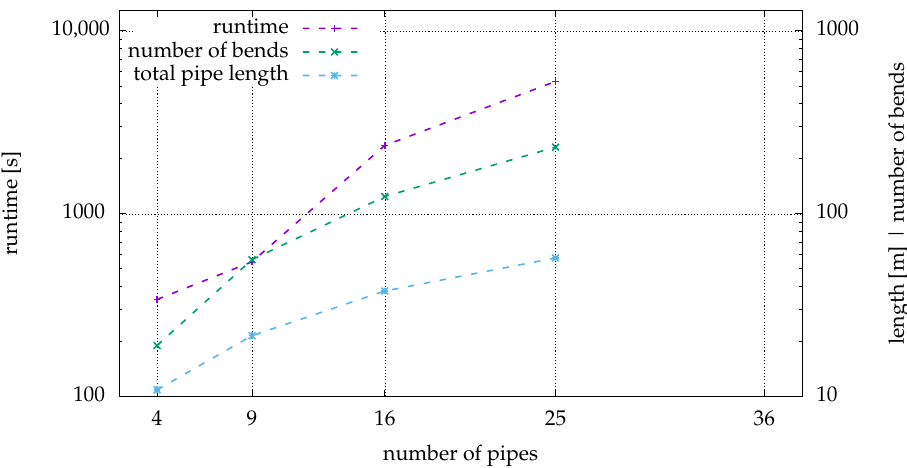
Figure 16. Relationship between the number of pipes, the runtime, the number of bends and the total pipe length with obstacle